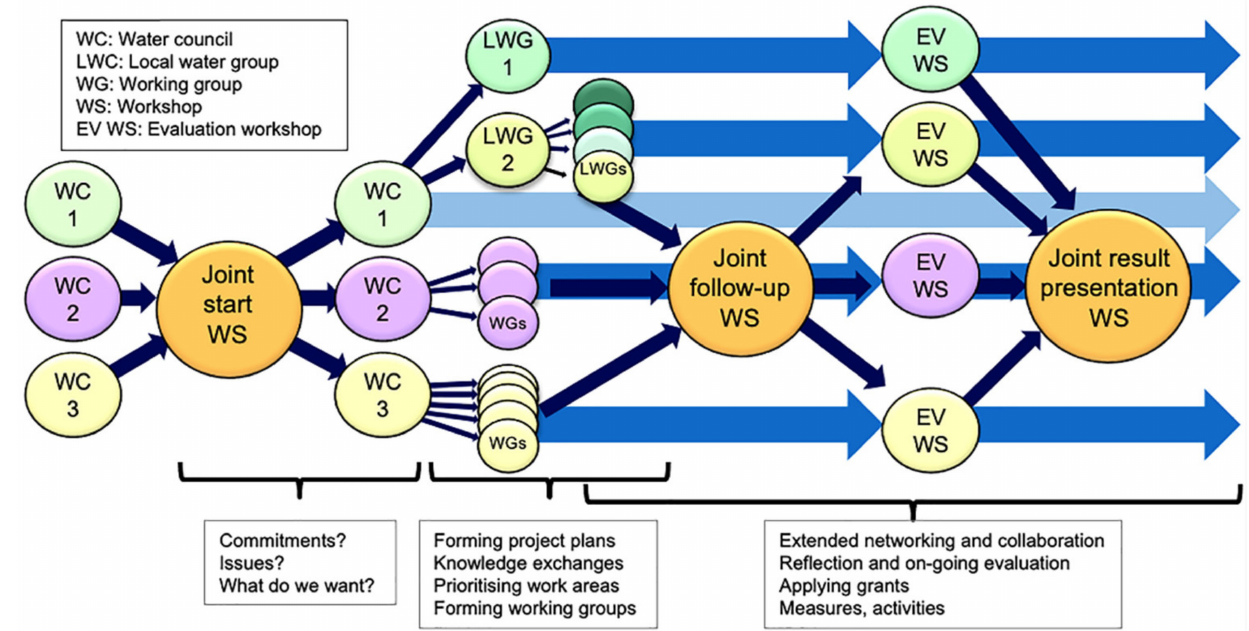
Figure 4. WaterCoG work processes in the pilots. Source: authors. Different activities were performed within, for example, measures, surveys, and information (Table